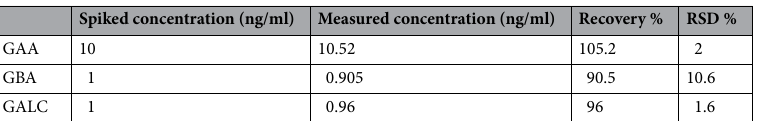
Spiked concentration (ng/ml) Measured concentration (ng/ml) Recovery % RSD